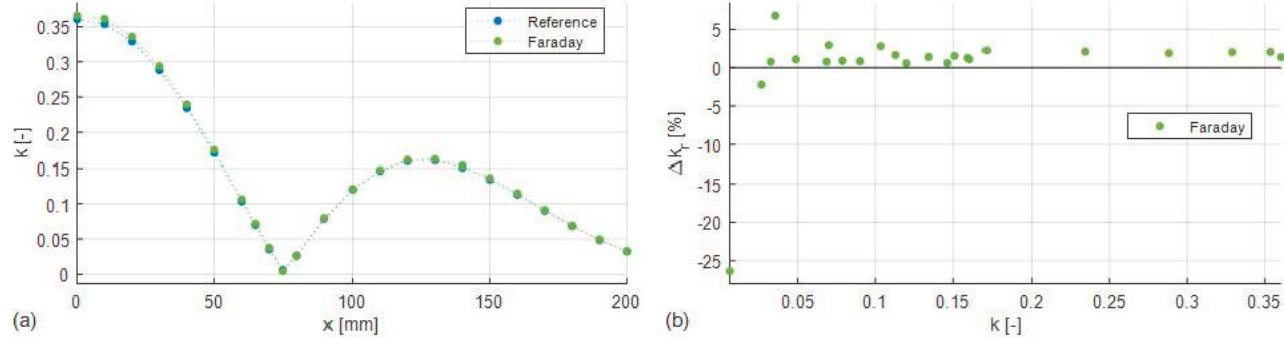
Figure 13. Method based on Faraday’s law. ( a ) Comparison with the reference measurement. ( b ) Relative error with respect to the reference over 𝑘 .